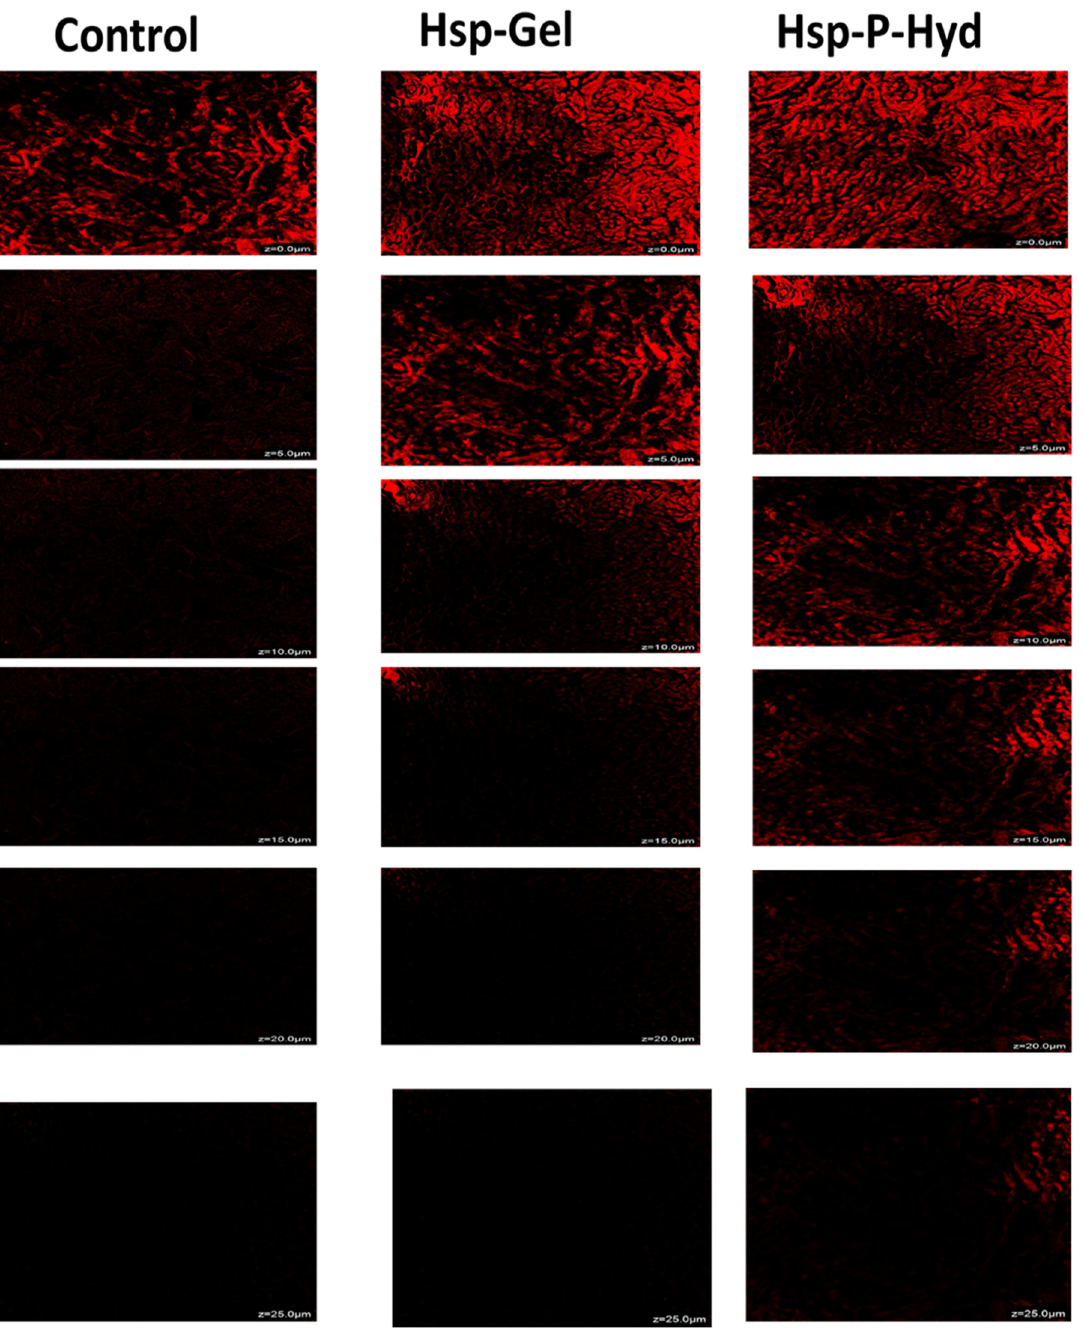
Figure 6. Confocal microscopic images of skin treated with a control, plain Hsp gel, and Hsp-PAMAM hydrogel bandage. In the control and Hsp gel-treated groups, the intensity of red fluorescence reached only 5 μ m, while a higher penetration was observed in those treated with Hsp-PAMAM, reaching a depth of 15 to 20 μ m.